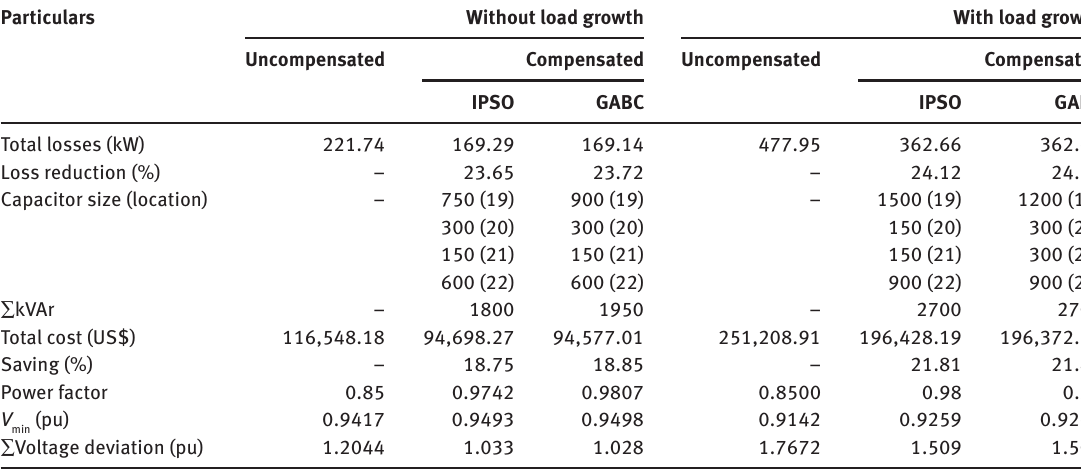
Table 5: Simulation Results of the 34-Bus Distribution Network after SC Placement Using the LSF Approach.